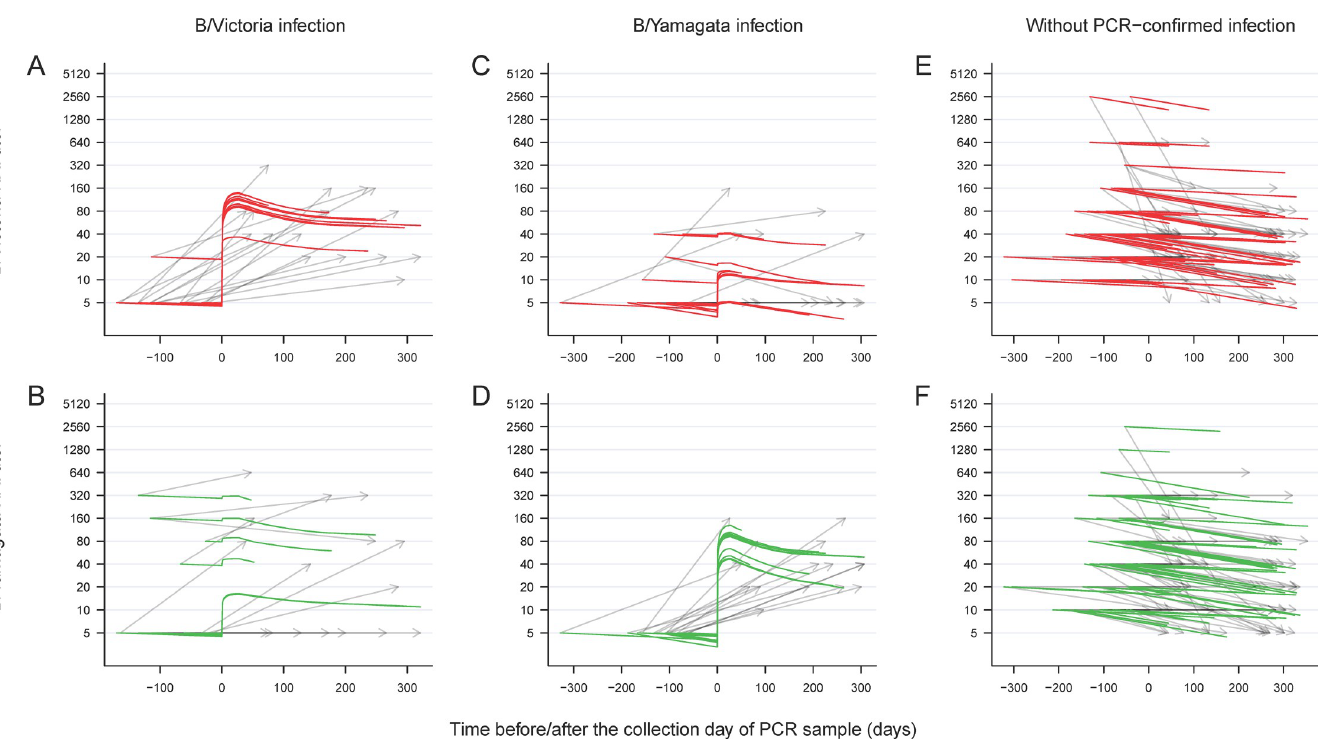
Fig 2. Modeled HAI antibody titer dynamics for the participants with and without PCR-confirmed infection in the sub-analysis. Antibody titers measured by the hemagglutination inhibition (HAI) assay against B/Victoria and B/Yamagata lineage viruses (black lines) versus modeled HAI antibody titer dynamics (coloured lines) for PCR-confirmed cases and participants without PCR-confirmed infection from August 2009 to December 2014 included in the sub-analysis.